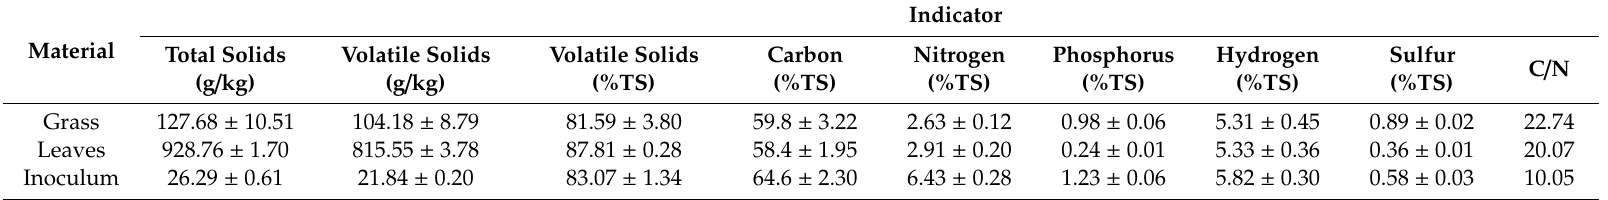
Table 1. Characteristics of substrates used for the